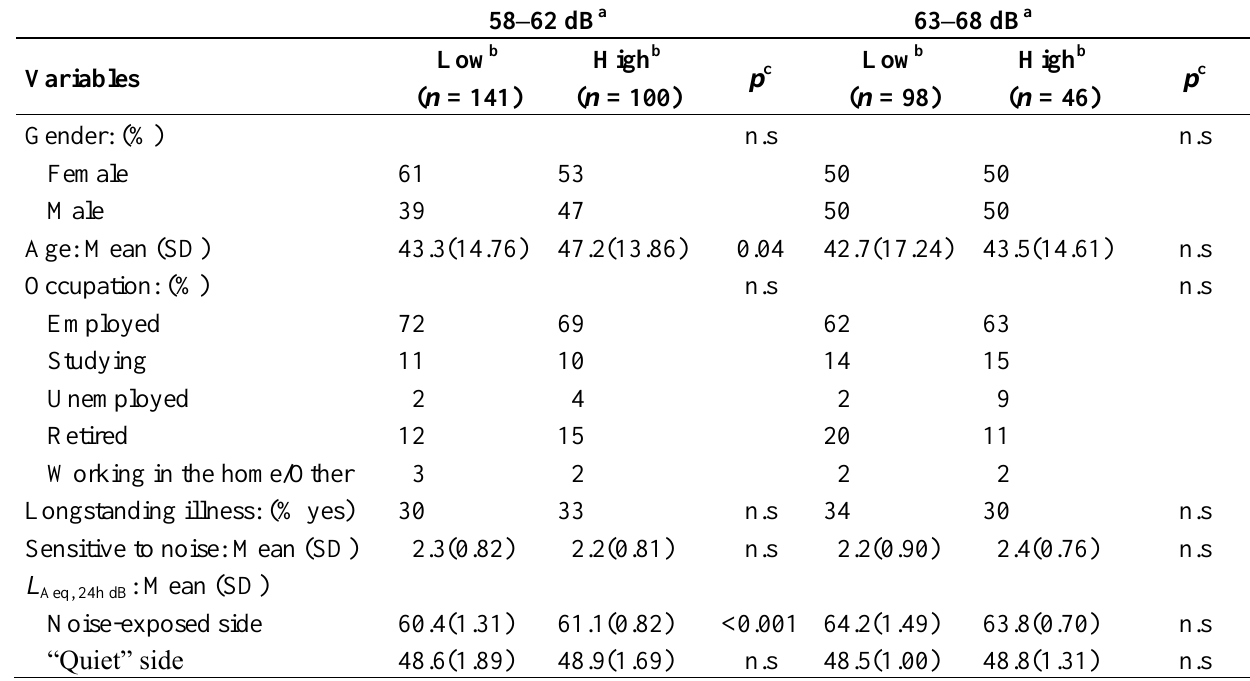
Table 3. Questionnaire responses on background variables and measured L relation to sound levels and access to a courtyard with low and high physical environmental quality.